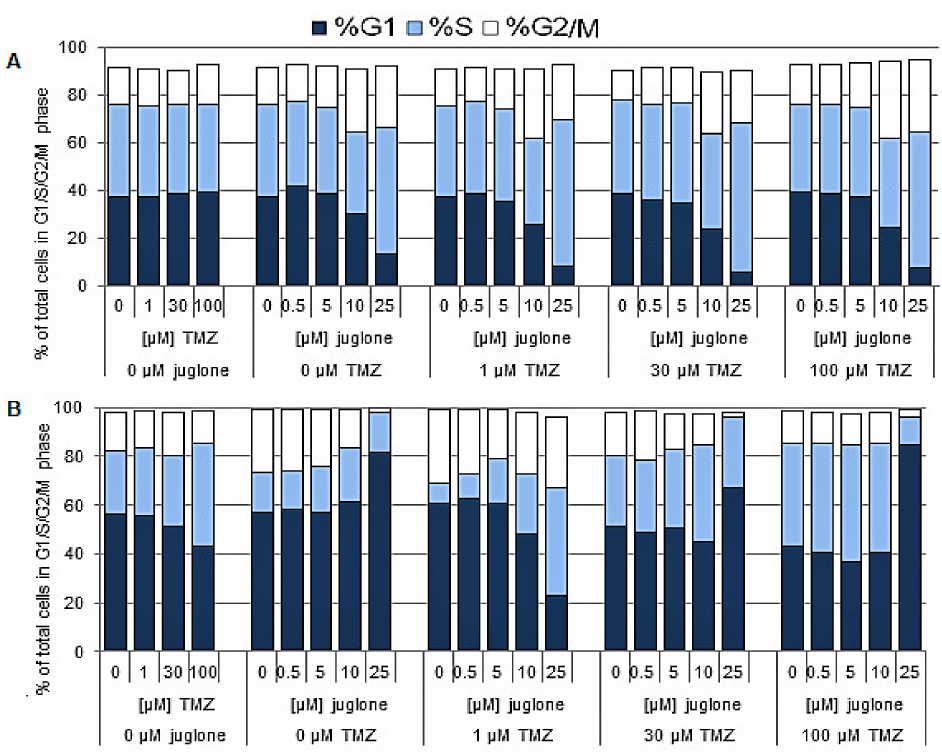
Figure 5. The effect of TMZ and juglone on the HaCaT ( A ) and T98G ( B ) cell cycle. The percentage of cells in each phase of the cell cycle is showed. All experiments were performed in